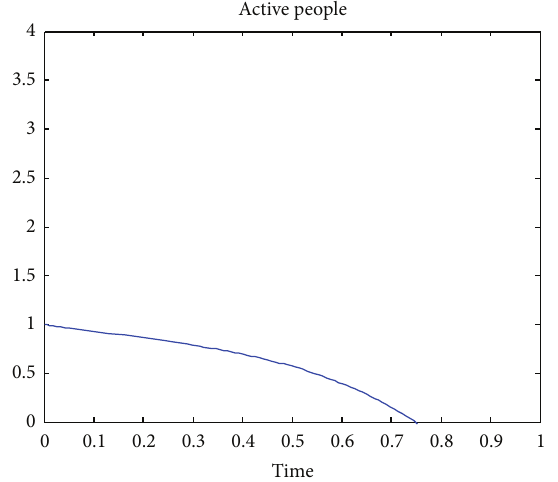
Figure 9: Approximate for 𝜇 = 0.045 , 𝜂 = 0.5 , and 𝜐 = 0.085